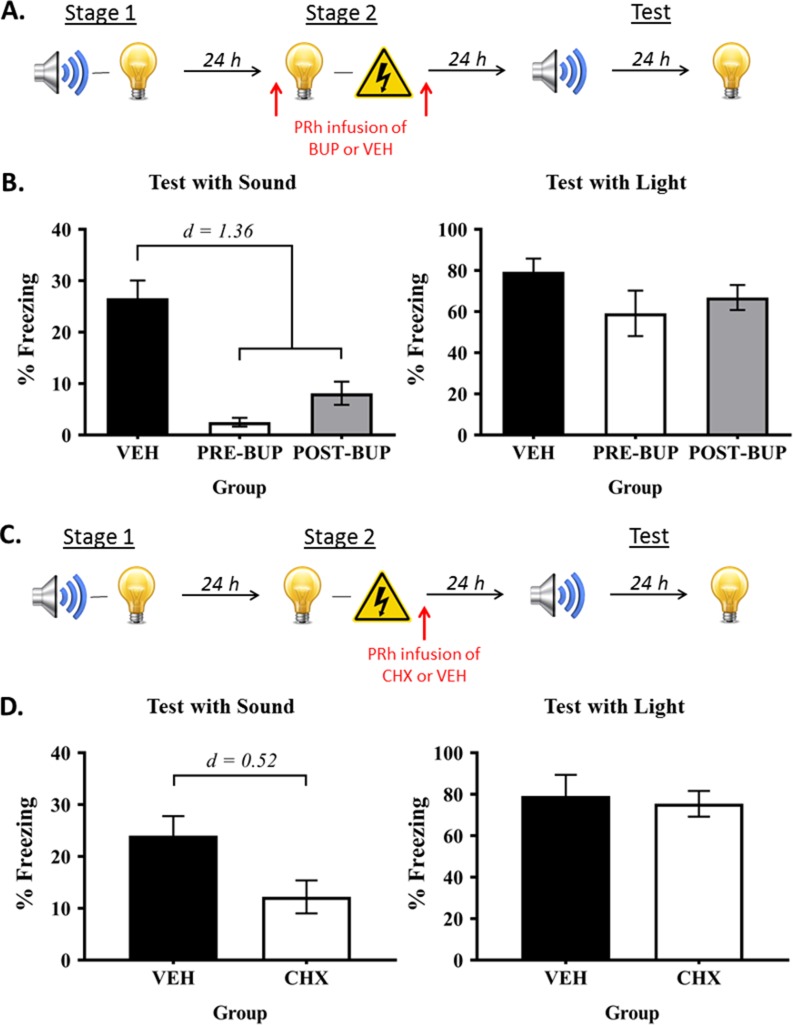
The PRh supports online integration of the sound-light and light-shock memories.(A) Behavioral procedure for Experiment 3 (Group VEH, n = 8; Group PRE-BUP, n = 6; and Group POST-BUP, n = 8). The red arrows indicate that the infusions of bupivacaine (BUP) or vehicle (VEH) occurred either before stage 2 or after stage 2. (B) Percentage freezing to the preconditioned sound (left panel) and to the conditioned light (right panel), averaged across the eight trials of their respective tests. Data shown are means ± SEM. The levels of freezing in both tests were analyzed using a set of planned orthogonal contrasts (Hays, 1963). The first contrast compared Group VEH versus the weighted average of Groups PRE-BUP and POST-BUP; and the second contrast compared Group PRE-BUP versus Group POST-BUP. Cohen’s d (d) is shown for statistically significant results. (C) Schematic of the behavioral procedure for Experiment 4 (Group VEH, n = 6; and Group CHX, n = 6). The red arrow indicates the infusions occurred immediately after stage 2. (D) Percentage freezing to the preconditioned sound (left panel) and to the conditioned light (right panel), averaged across the eight trials during their respective tests. Data shown are means ± SEM, and Cohen’s d (d) for statistically significant results. It is worth noting that the level of freezing to the sound in each of the treatment groups was not significantly different from the baseline (Fs < 1). We take this result to mean that the infusion of bupivacaine or cycloheximide into the PRh before/after stage 2 training completely blocked formation of the mediated sound-shock association. For raw data, see the Figure 4—source data 1.10.7554/eLife.47085.008Figure 4—source data 1.The PRh supports online integration of the sound-light and light-shock memories.